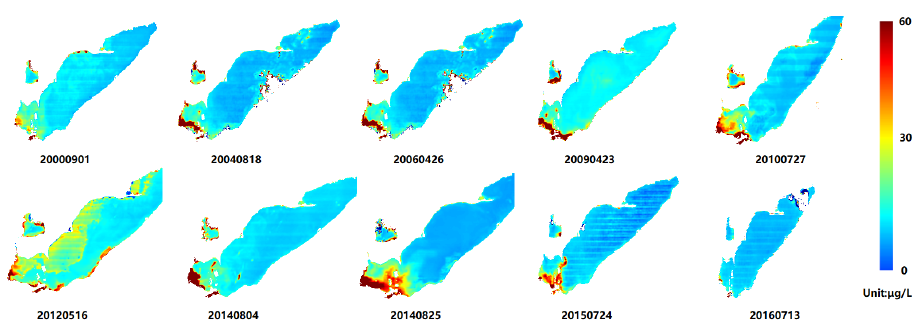
Figure 5. Spatial distributions of TP in Lake Erie from 2000 to